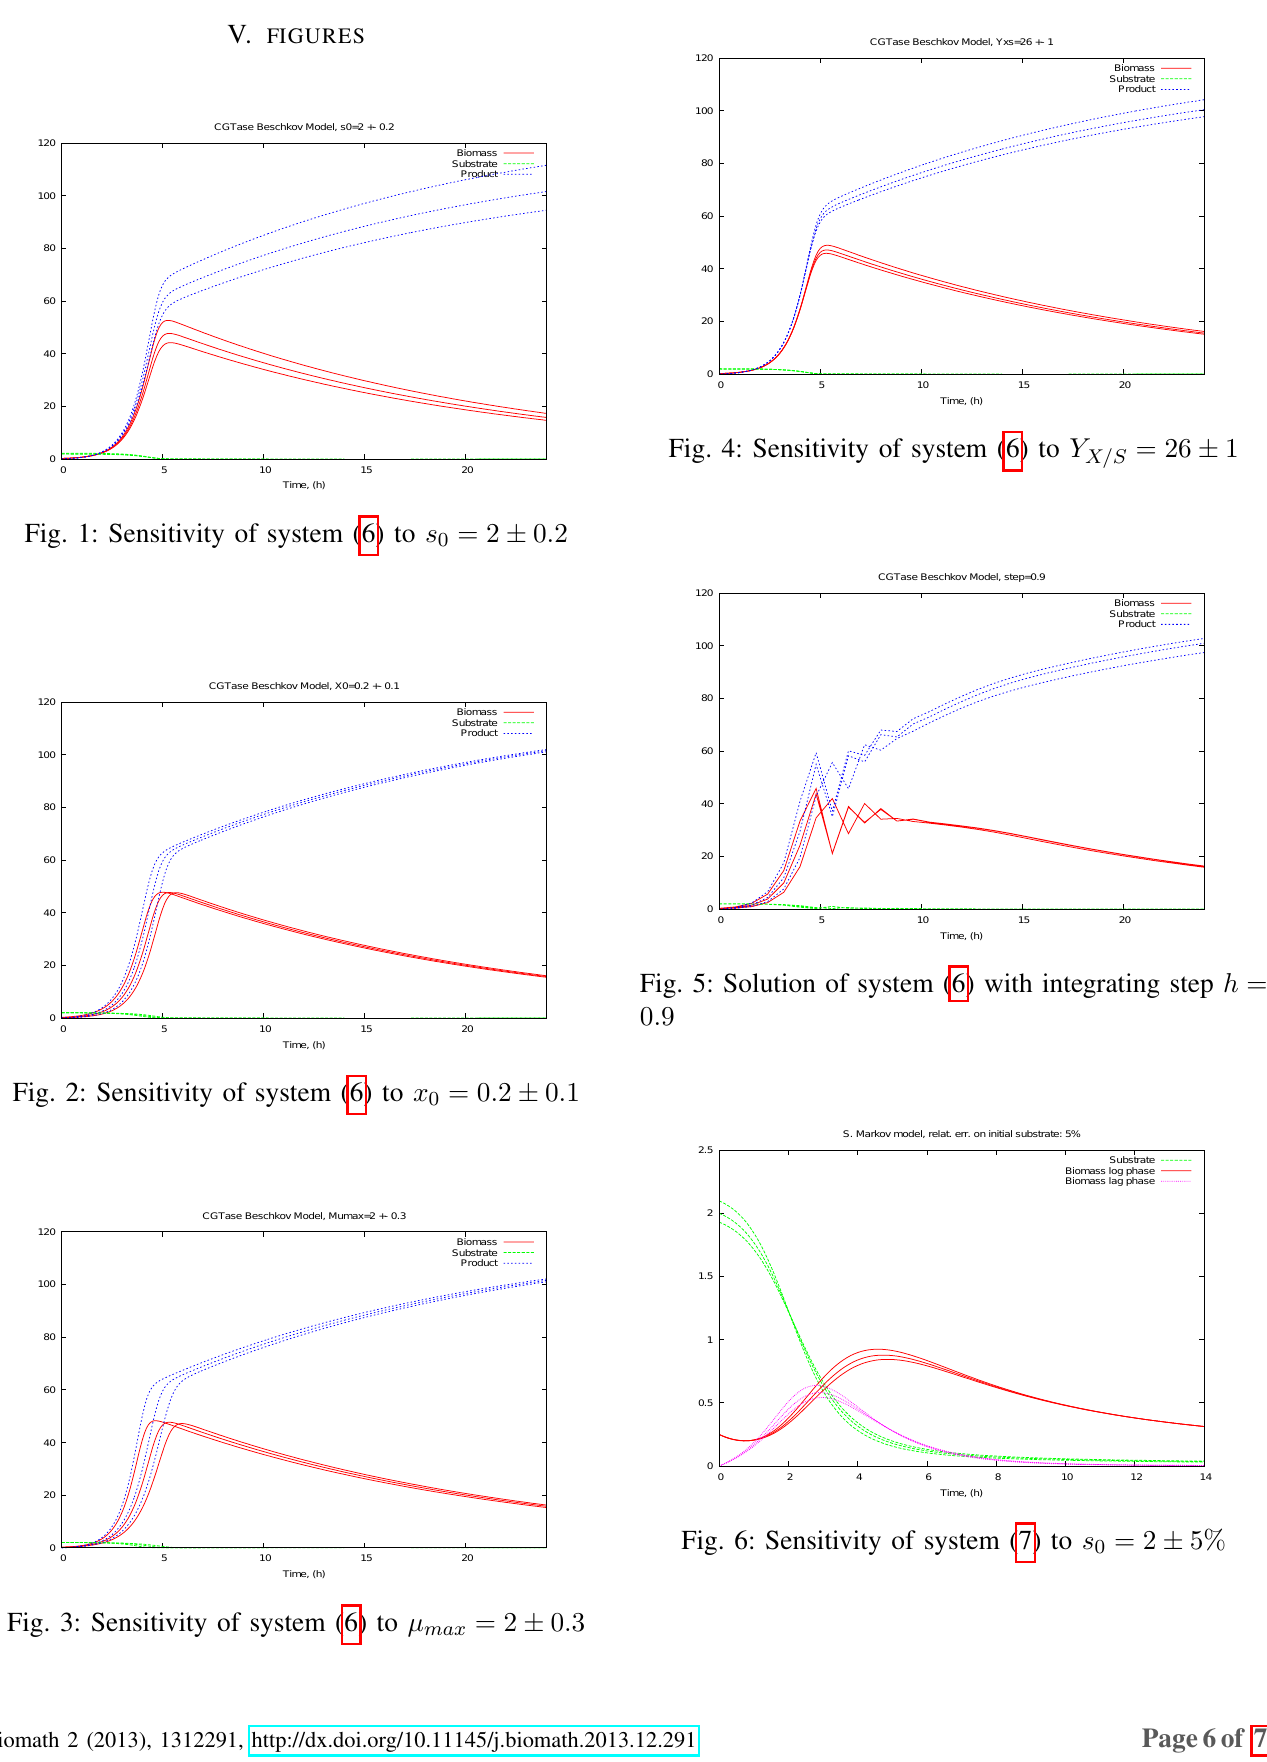
Fig. 4: Sensitivity of system (6) to Y